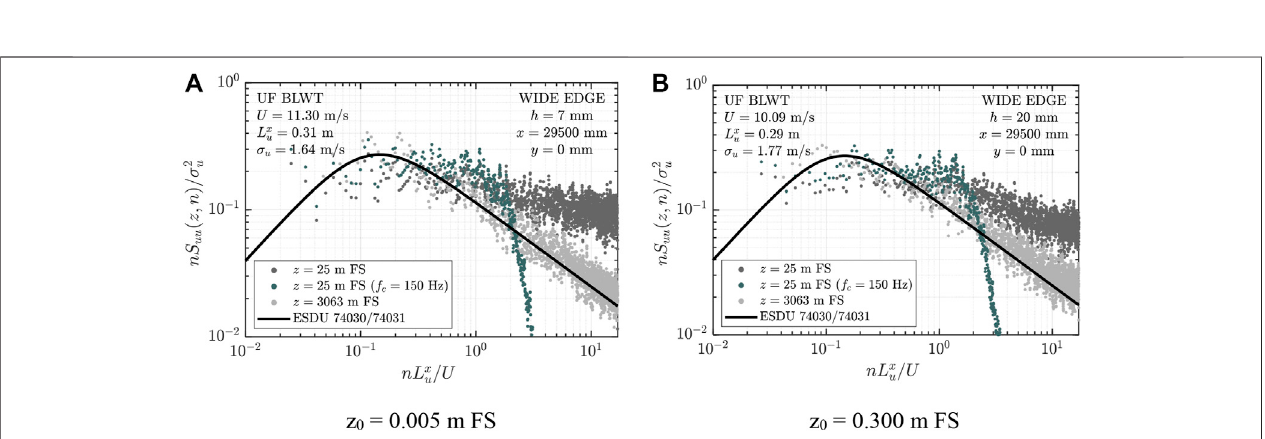
Frontiers in Built Environment |